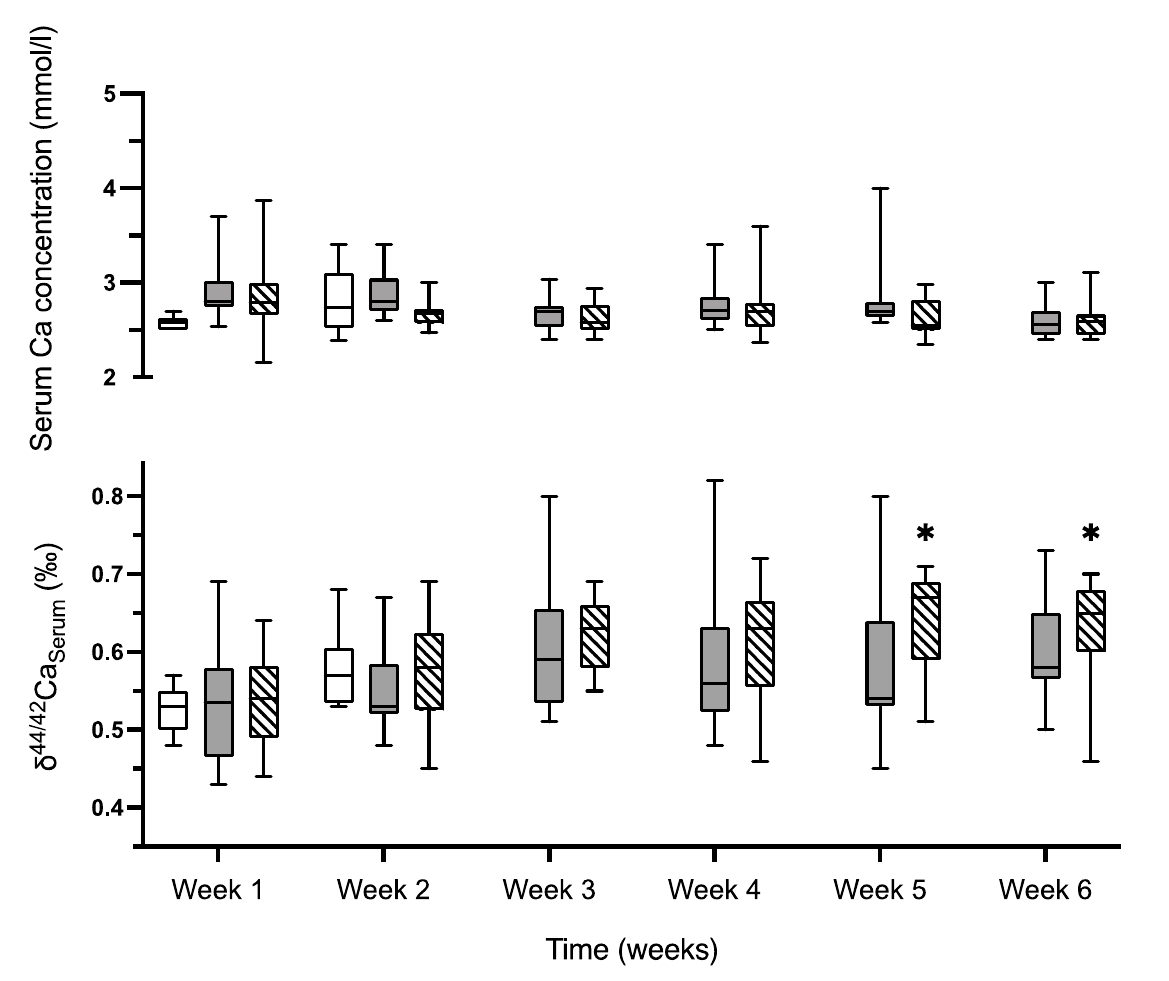
Figure 1. Serum Ca concentrations and δ 44/42 Ca Serum. Serum Ca concentrations (upper y-axis) and δ 44/42 Ca Serum (lower y-axis) were measured weekly in the baseline group (0.5% Ca diet for two weeks, empty boxes, n = 9), the standard-diet group (six weeks 0.5% Ca diet, gray boxes, n = 13) and the low-Ca-diet group (two weeks 0.5% Ca diet followed by four weeks of 0.25% Ca diet, hatched boxes, n = 13). Minimal and maximal values (whiskers), the interquartile range (box) and the median (solid line) are plotted. Serum Ca concentrations were similar in all three groups throughout the study, δ 44/42 Ca Serum increased in animals on low-Ca-diet (ANOVA, p = 0.007), reaching significantly higher values at week five and six (ANOVA, * p < 0.05 versus week two). Table 2. Femur Ca content after two weeks on standard-diet (group 1, 0.5% Ca) and a subsequent four weeks of standard-diet (group 2) and low-Ca-diet (group 3, 0.25%